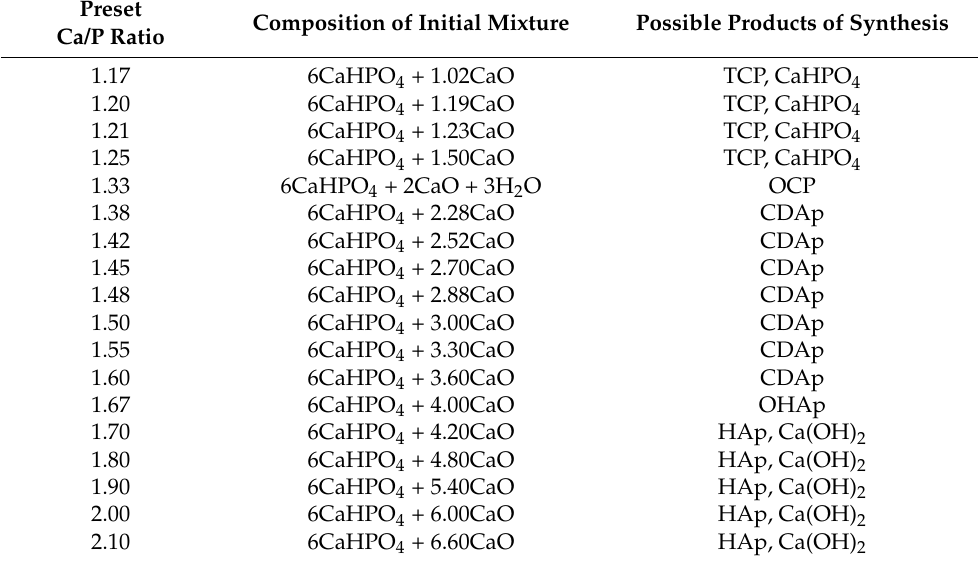
Table 1. Reactions of mechanochemical synthesis of calcium phosphates and the intended composi- tion of their products. Preset Composition of Initial Mixture Possible Products of Ca/P Ratio